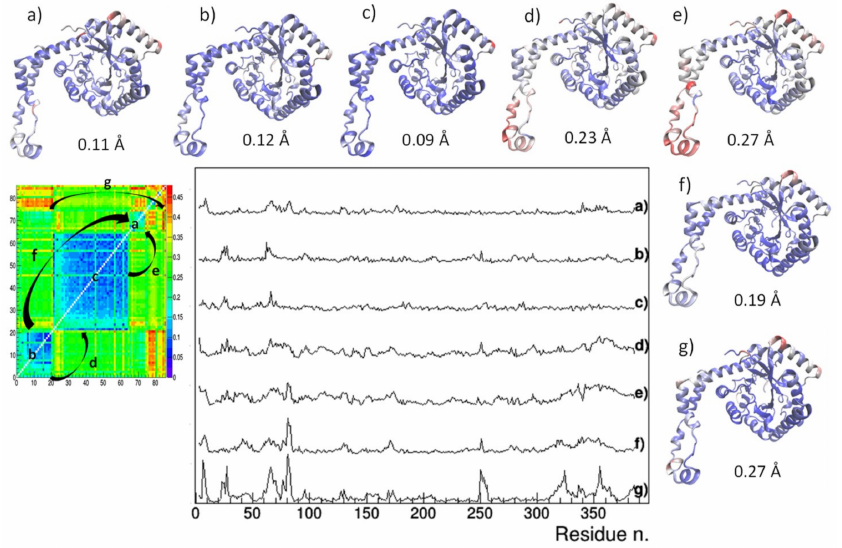
Figure 5. Reside-by-residue root-mean-square deviation (RMSD) of C α atoms between pairs of representative glucose isomerase crystal structures. They are: IL-1 – 4zbc ( a ), REF-1 – 4zb5 ( b ), 1xib-5i7g ( c ), REF-1 – 1xib ( d ), IL-1 – 1xib ( e ), IL-1 – REF-1 ( f ), 5avh – 5avn ( g ) and are indicated within the distance matrix after application of hierarchic clustering. Structural models colored according to rescaled residue-by-residue RMSD values are shown, together with the average RMSD